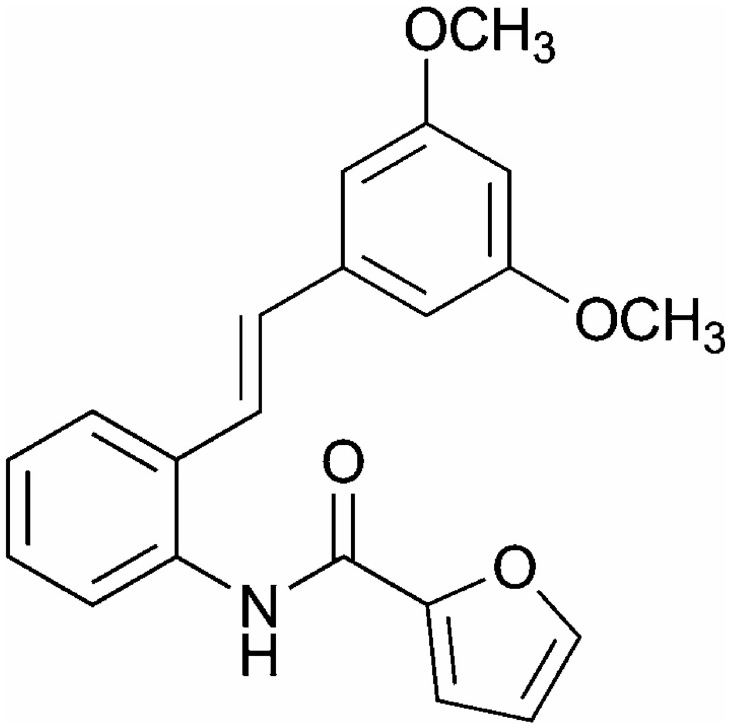
Fig 1. Chemical structure of BK3C231